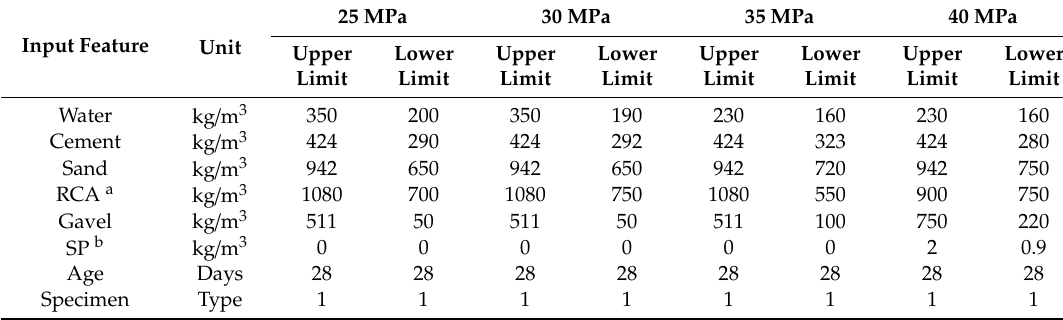
Table 8. Bounder vectors for mixture optimization.